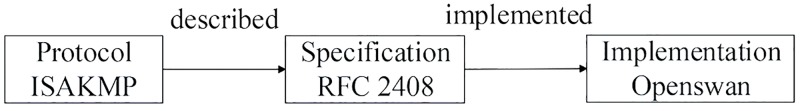
The relationship among protocol, specification and implementation of ISAKMP protocol.